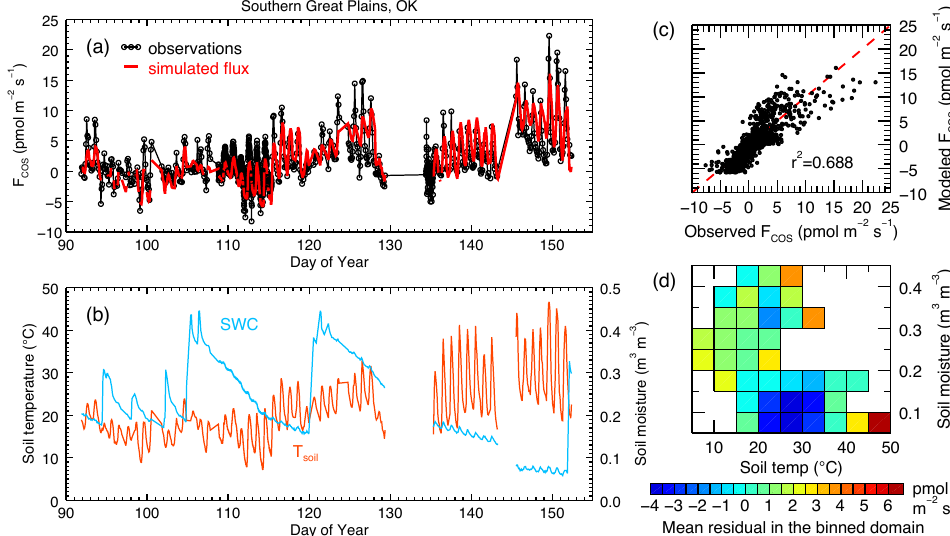
Figure 5. (a) Observed COS fluxes (black) and modeled COS fluxes (red) at the Southern Great Plains site. (b) Surface soil temperature and moisture at the site during the same period. (c) Model vs. data for COS fluxes. (d) Mean residuals (observed − modeled) binned by 5 ◦ C soil temperature and 0.05m 3 m − 3 soil moisture steps.